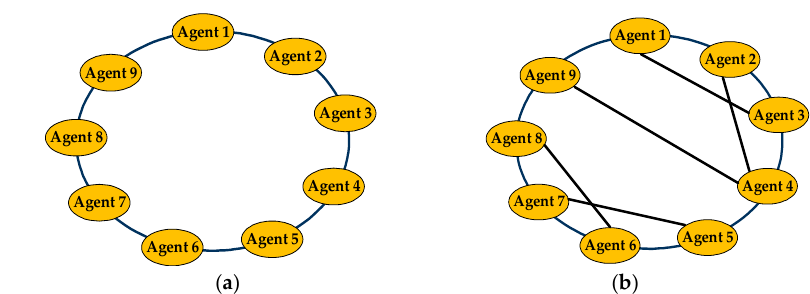
Figure 11. Different topologies for connection of the local controller agents: ( a ) topology a; ( b ) topology b.